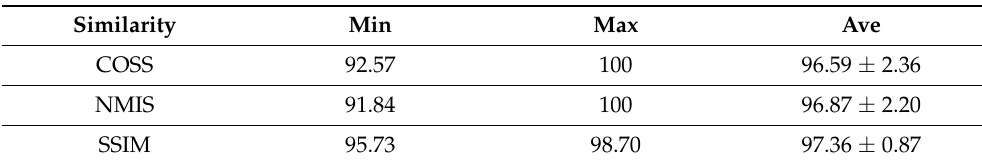
Table 8. Training Scenario II: recognition results of gradual domain adaptation recognition framework with pseudo-label denoising using different similarities